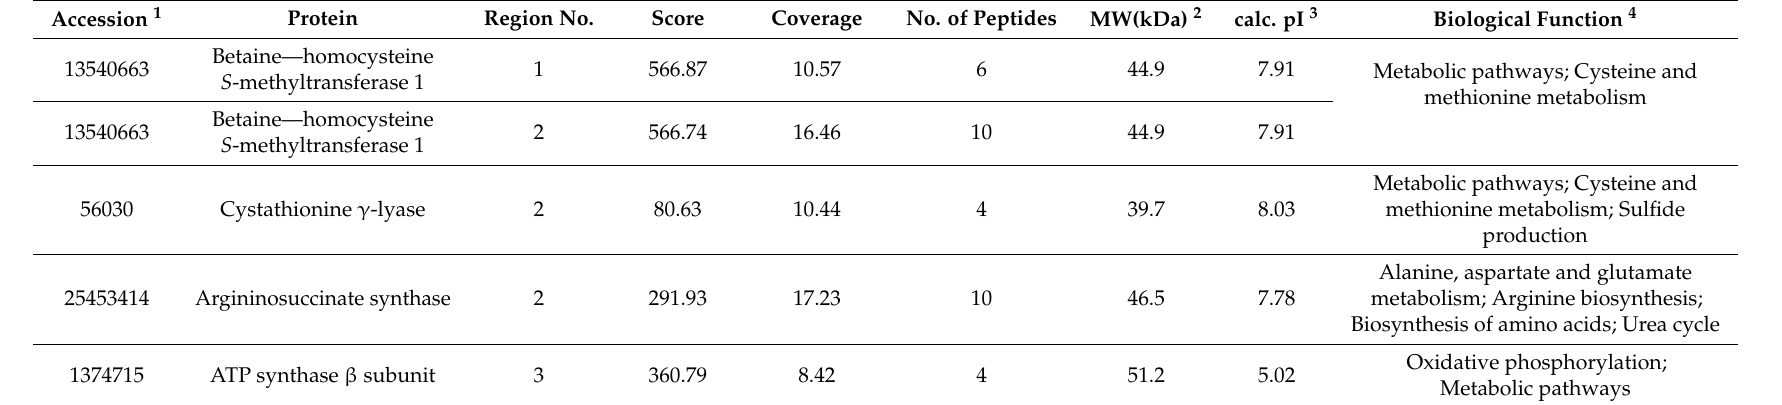
Table 1. Candidate proteins by MS identification and image